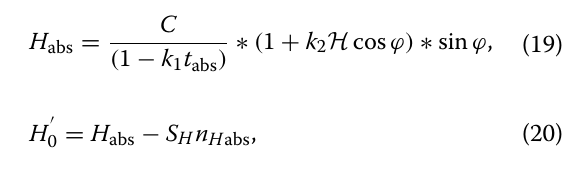
Table 3 Uncertainties for H component Variable Value of the variable Uncertainty (δ) Term Uncertainty of the variable